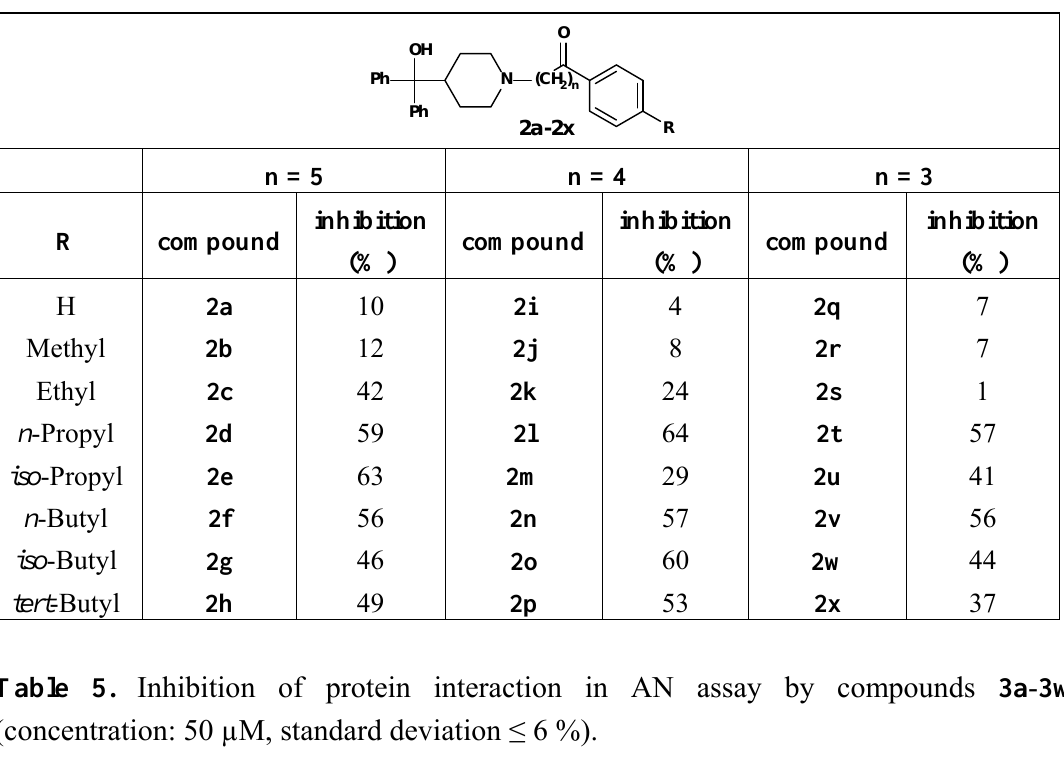
Table 4. Inhibition of protein interaction in AN assay by compounds 2a - 2x (concentration: 50 µM, standard deviation ≤ 6 %).